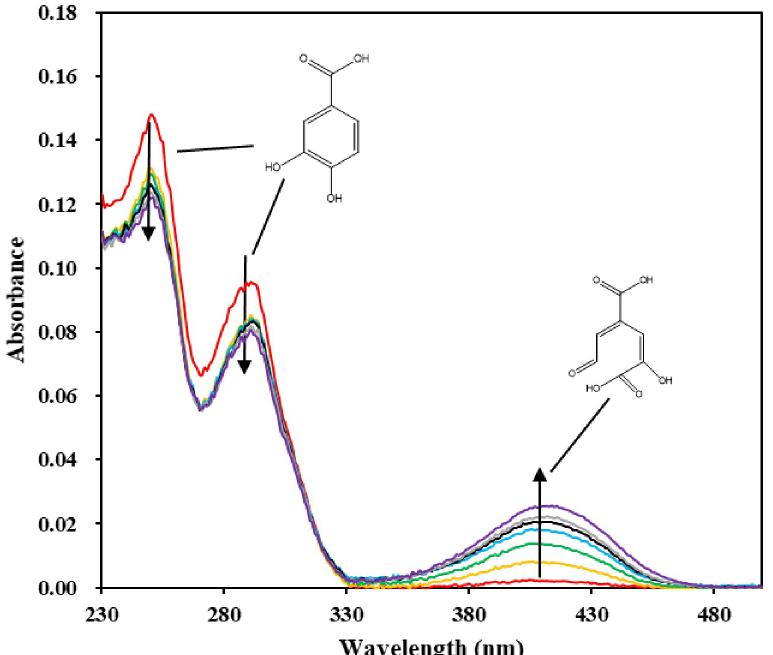
Fig 9. Spectrophotometric analysis of ZXY12VA15 enzyme activity. Absorbance increase of 4-carboxy- 2-hydroxymuconate-6-semialdehyde ( λ max , 410